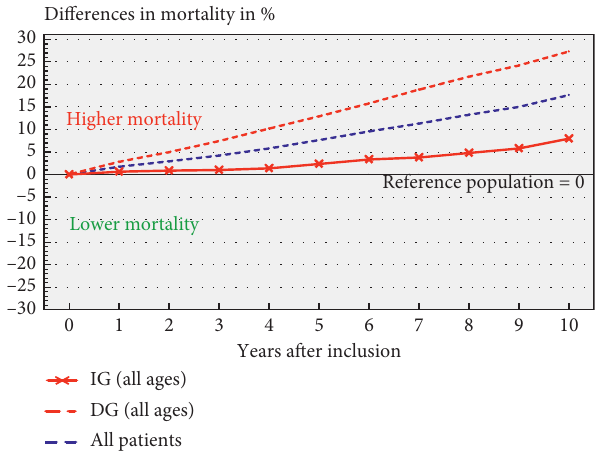
Figure 1: Life table survival curves for all included patients ( N � 8463) and for the two subgroups (DG and IG) compared to the reference population at the same age interval during 10 years of follow-up. Difference in mortality compared to the corresponding reference population was significant for all groups ( p < 0 . 05).